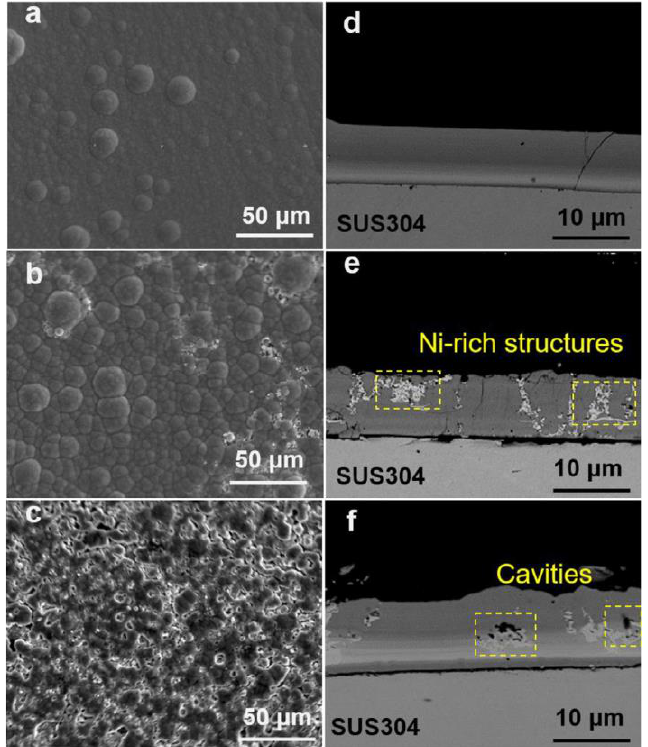
Figure 5. SEM micrographs of the surface ( a – c ) and cross-sectional micrographs ( d – f ) of coatings